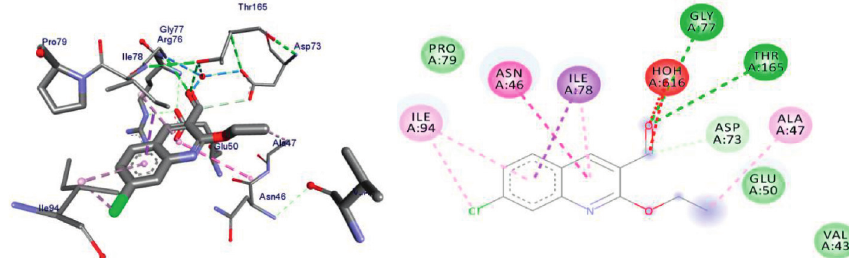
Figure 5: The binding interactions of compound 8 against E. coli DNA gyrase B (PDB ID